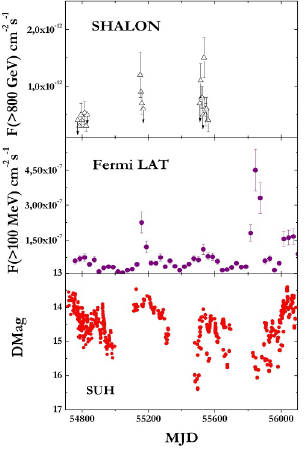
Figure 2. Comparison of OJ 287 light curve by SHALON in the energy range 800 GeV − 35 TeV (upper plot) with data in the MeV-GeV energies by Fermi LAT (middle) and in R-band by Suhora Astronomical Observatory. A slight local flux increase can be seen in the period of November 2010 in Fermi LAT data [16] and at R-band, which corresponds to the above-mentioned γ -ray flux increase observed by SHALON in 2010. The increase of OJ 287 flux in 2009 SHALON data correlates with flares in MeV-GeV energies and